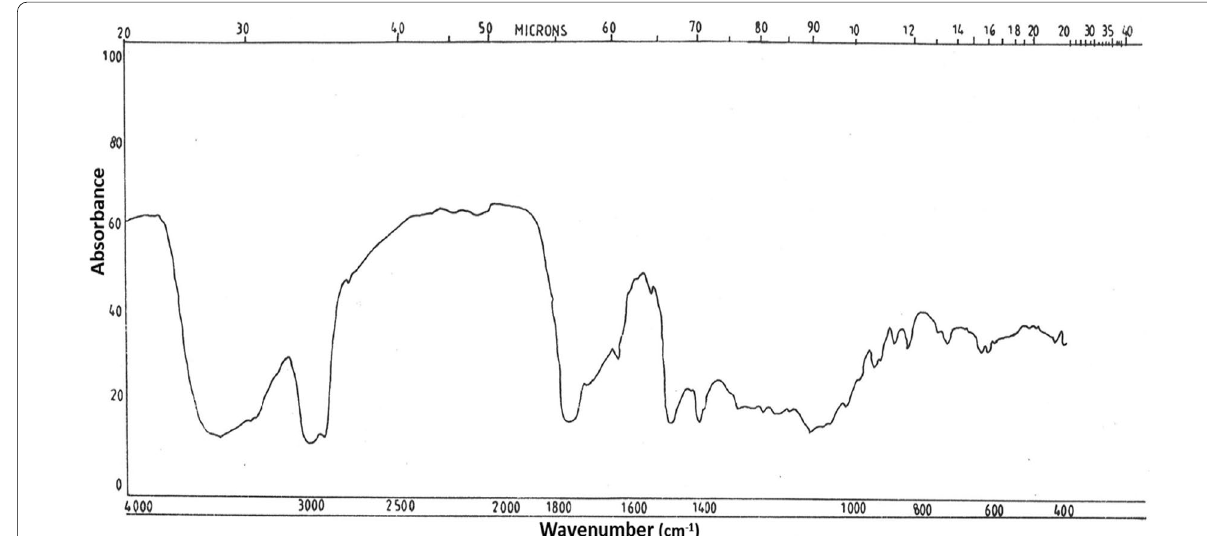
Fig. 3 Infrared spectrum of antifungal compound (Saponin) from A. racemosus